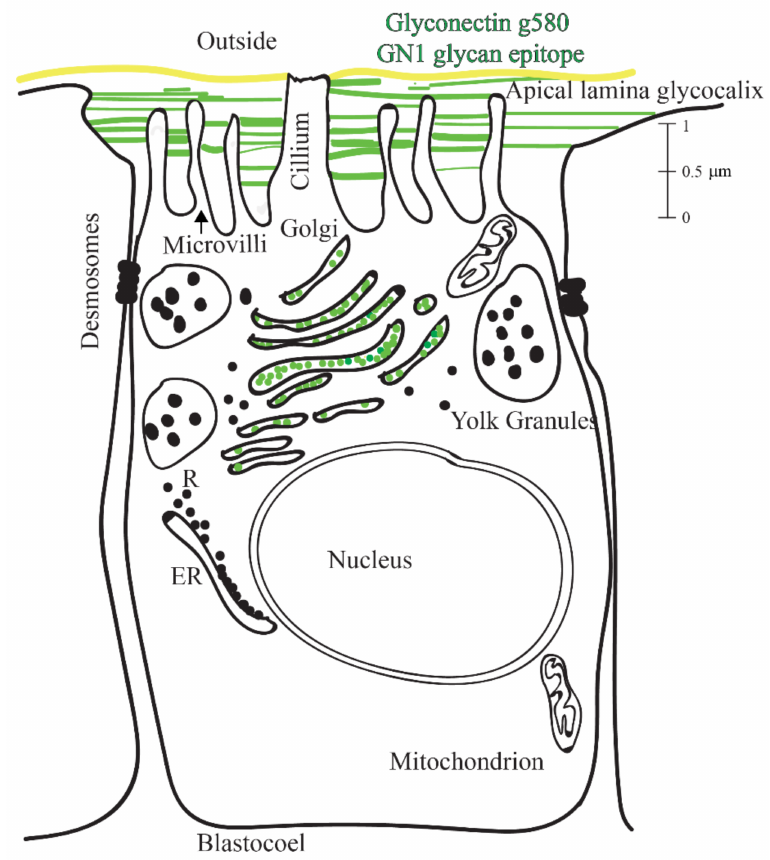
Figure 4. Model of hatched blastula apical lamina glycocalyx association with microvilli by the g580 glyconectin acidic